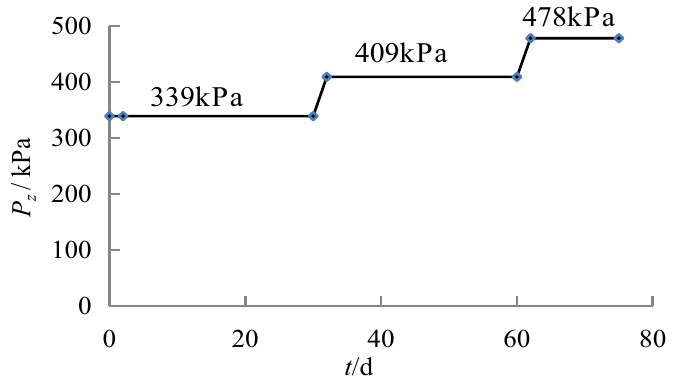
Figure 7. Loading process of the caisson Sections 8–10.